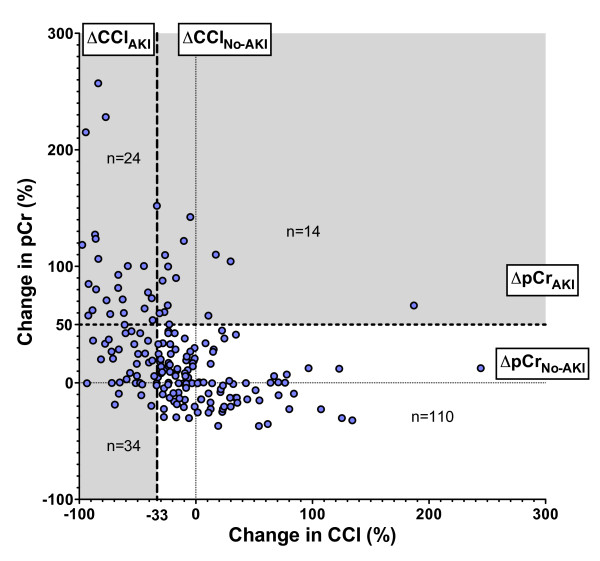
Comparison of percentage increase in plasma creatinine (pCr) with percentage decrease in creatinine clearance (CCl) from known baseline to entry into the ICU. Four quadrants are shown: (i) No AKI (ΔpCrNo-AKI and ΔCClNo-AKI), (ii) AKI by the clearance criterion only (ΔpCrNo-AKI and ΔCClAKI), (iii) AKI by the pCr criterion only (ΔpCrAKI and ΔCClNo-AKI) or (iv) AKI by both criteria (ΔpCrAKI and ΔCClAKI). AKI: acute kidney injury; No-AKI (CClNo-AKI): without AKI; ΔpCr: relative change in pCr from baseline; ΔCCl: relative change in CCl from Cockcroft-Gault (CG) baseline; AKI (pCrAKI): with AKI.